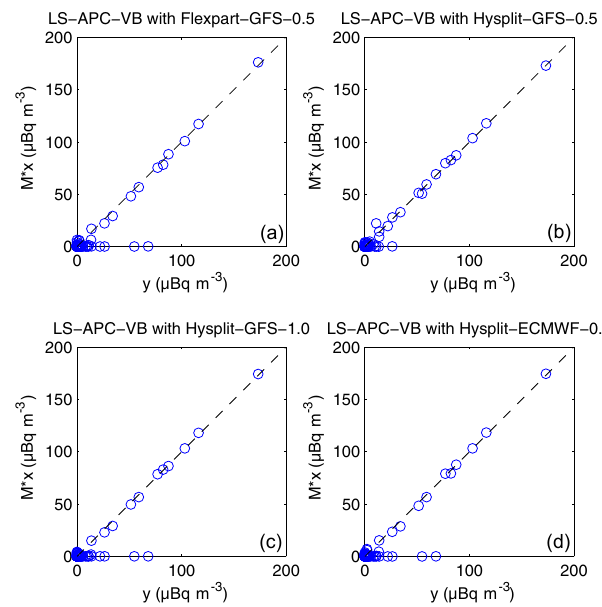
Figure 4. Scatter plots of the measurements y and the reconstructed signal M x using the LS-APC-VB algorithm with Flexpart-GFS- 0.5 (a) , Hysplit-GFS-0.5 (b) , Hysplit-GFS-1.0 (c) , and Hysplit- ECMWF-0.5 (d) . The reconstructions are given for the estimated source locations, shown in Fig. 2, and the mean values of the esti- mated source terms, shown with blue lines in Fig.